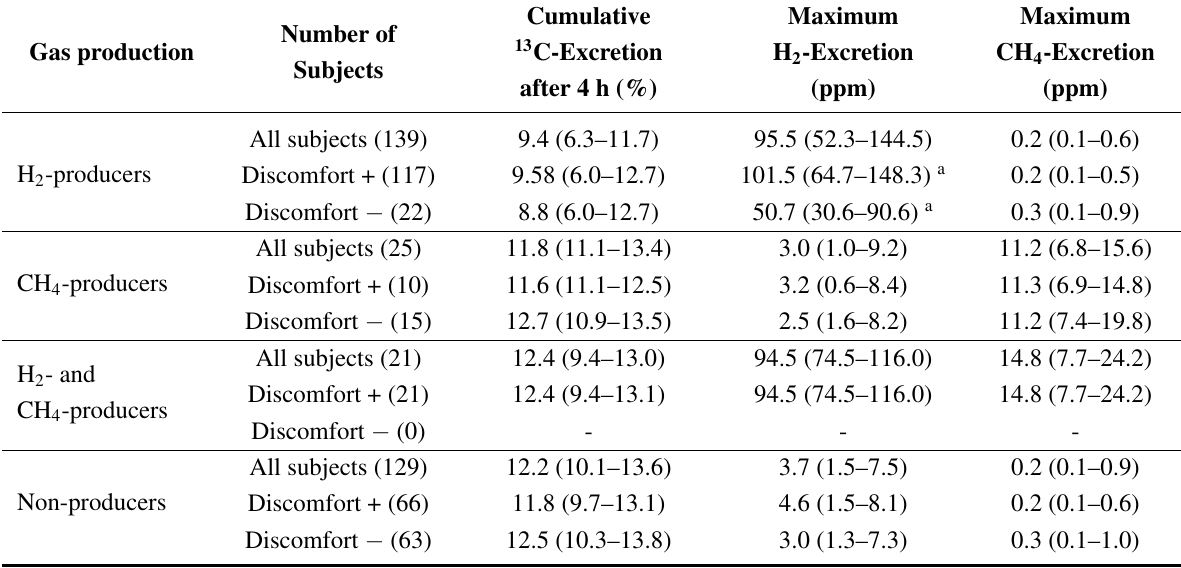
Table 2. 13 CO , H and CH excretion in patients with lactase deficiency. 2 2 4 Table 2. 13 CO 2 , H 2 and CH 4 excretion in patients with lactase deficiency.